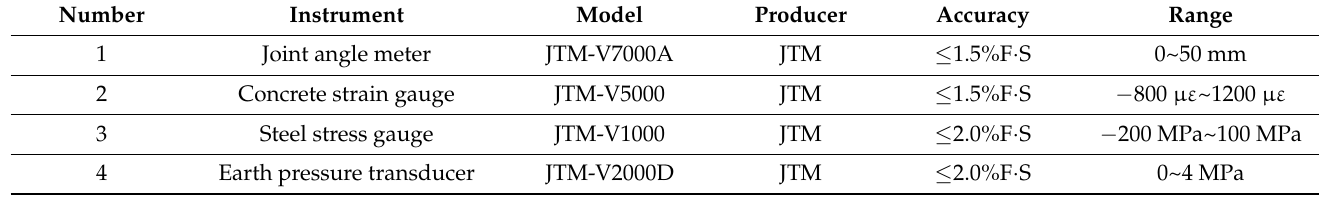
Table 1. Detailed information on the sensors.